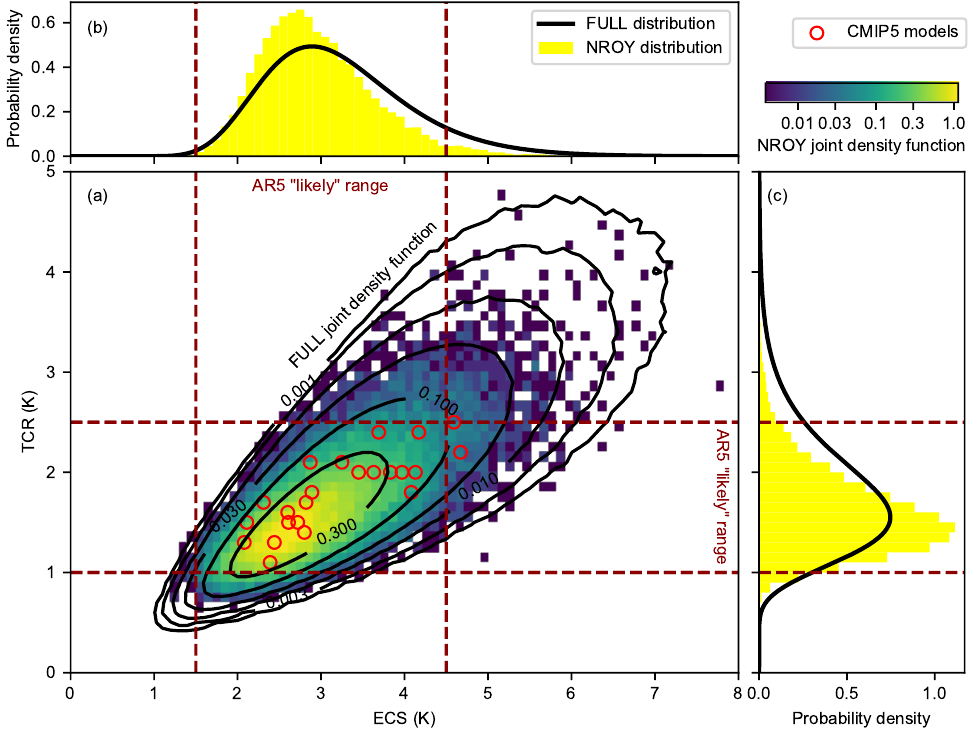
Figure 3. (a) Joint distributions (FULL and NROY) of ECS and TCR. (b) Marginal distributions of ECS. (c) Marginal distributions of TCR. In (a) , the FULL distribution is shown with open black contours and the NROY distribution with coloured squares. Probability density is plotted on a log scale. In (b) and (c) , the FULL distribution is shown as a black curve and the NROY distribution with yellow histogram bars, both plotted on a linear scale. The NROY distributions contains only those ensemble members which agree with the C&W observed historical temperatures. CMIP5 models are depicted with red